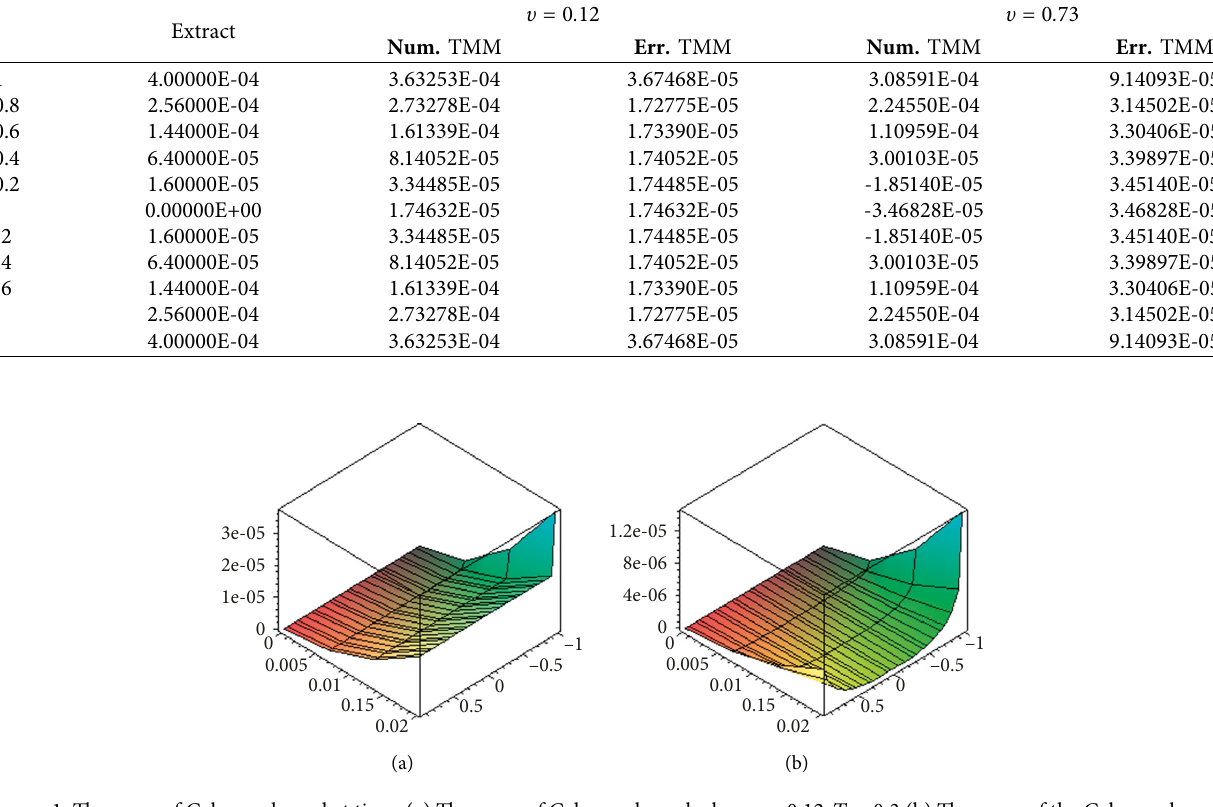
Figure 1: The error of Caleman kernel at time. (a) The error of Caleman kernel when υ when. υ 0 . 72 ,T 0 . 3 (cid:27) (cid:27)